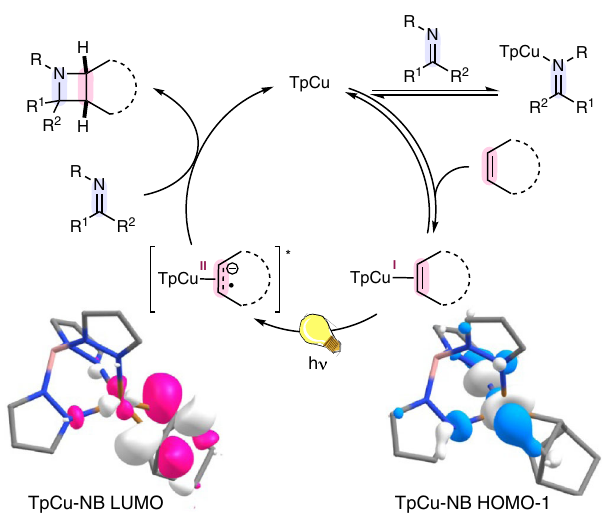
Fig. 4 Mechanistic proposal of the title reaction. The proposed 2 + 2 IOPC mechanism commences with ole fi n substrate coordination to TpCu. Ligand exchange experiments indicate that imine substrates undergo rapid and reversible coordination to TpCu. The active TpCu-ole fi n chromophore then undergoes a MLCT from computationally visualized TpCu-NB HOMO-1 which is primarily Cu-based to TpCu-NB LUMO which is ole fi n( π *)-based. Capture by the imine C = N double bond leads to azetidine formation and release of